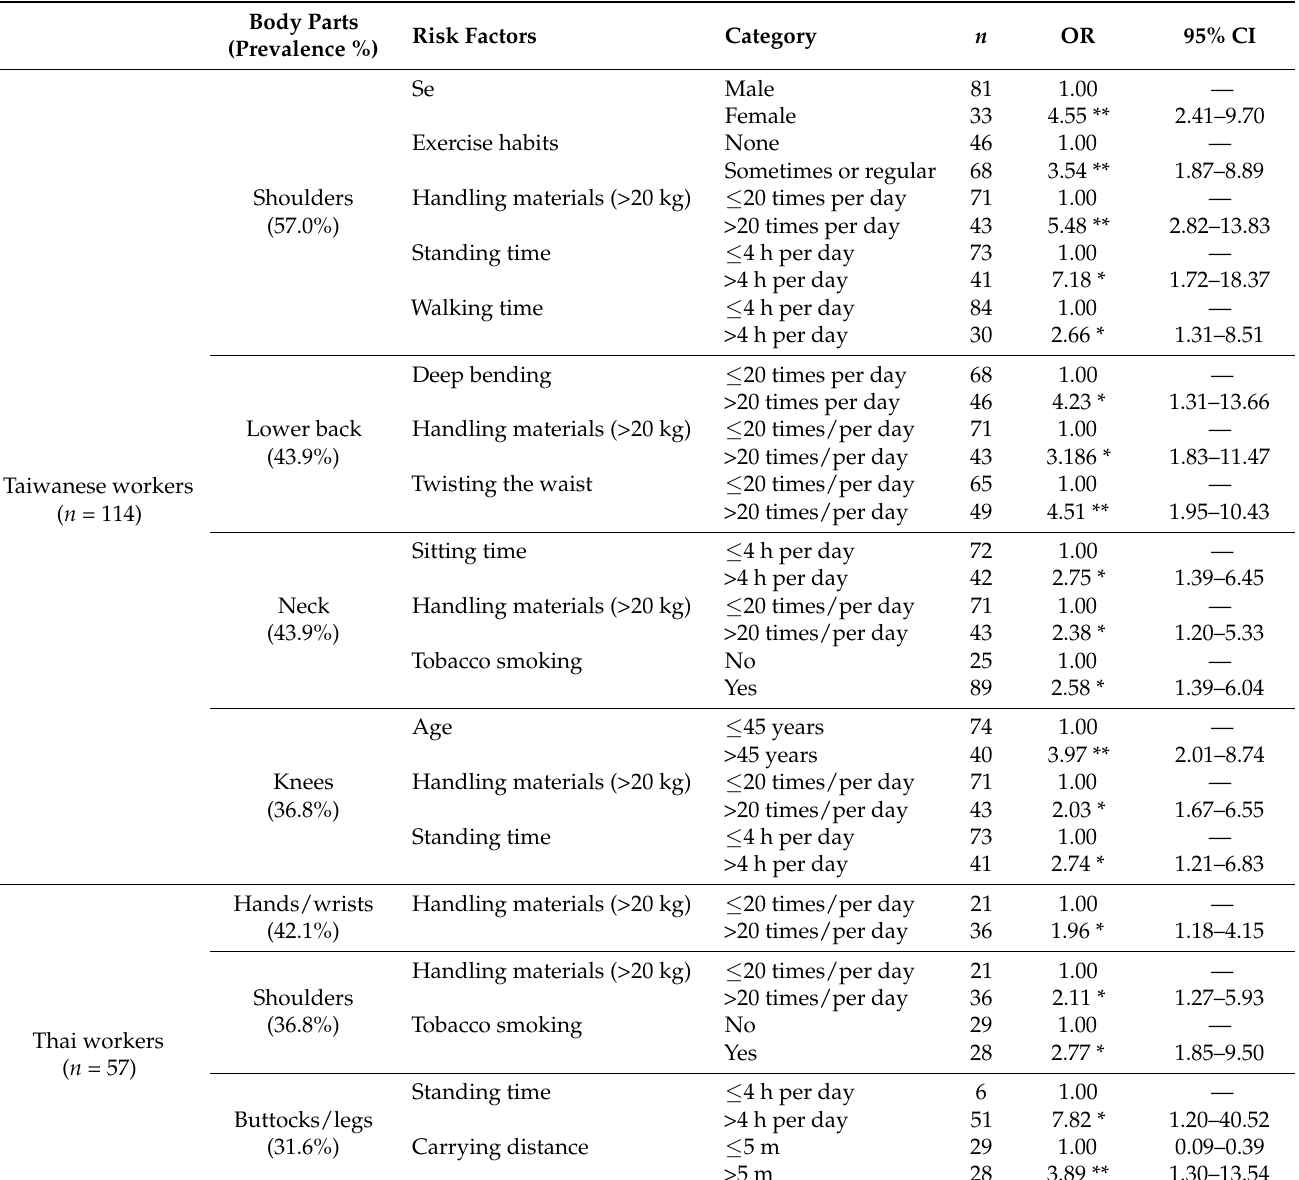
Table 4. Risk factors significantly associated with musculoskeletal disorder symptoms (prevalence >